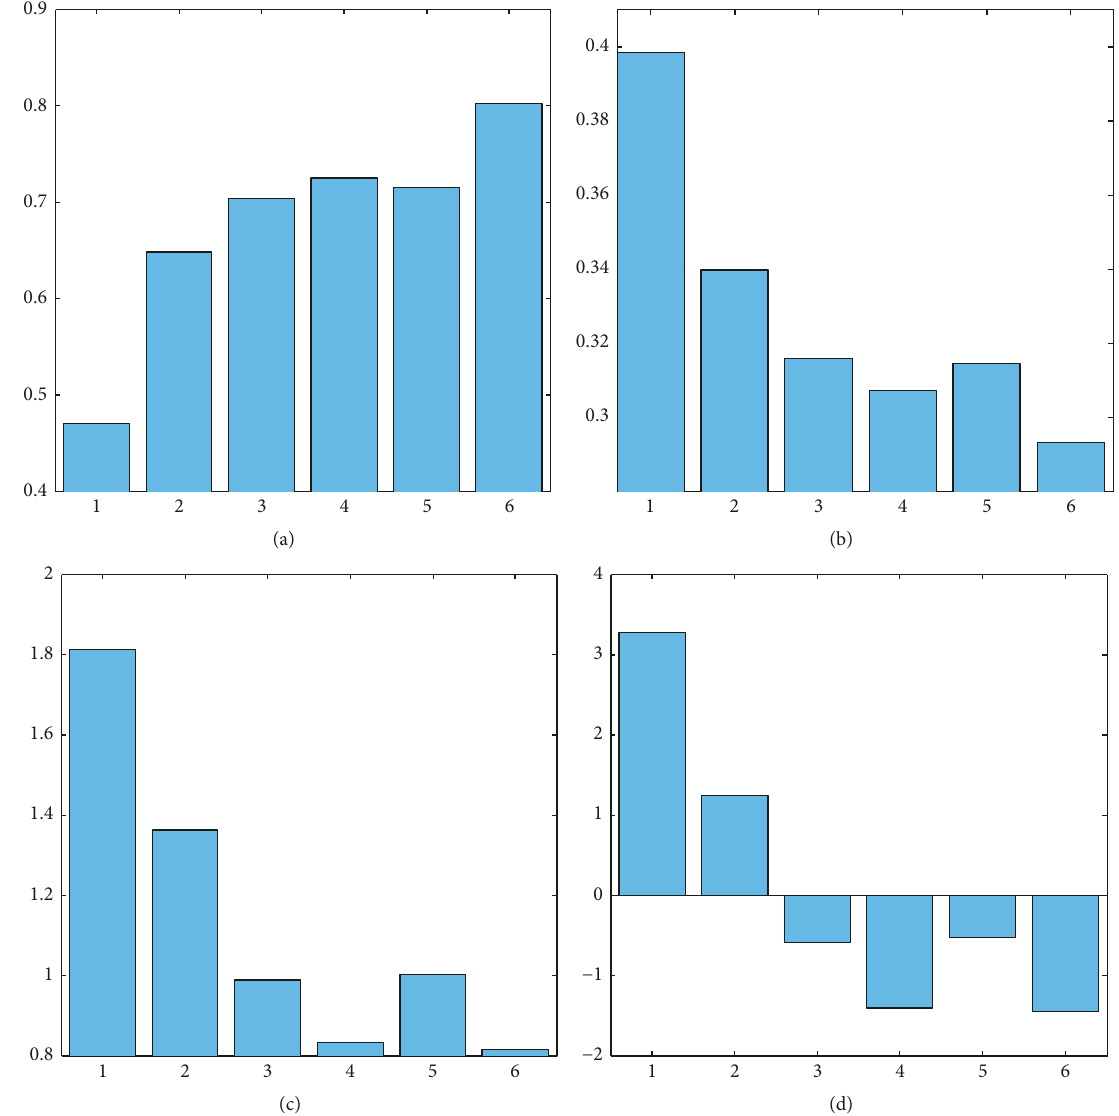
Figure 3: Four indexes changes with age: (a) entropy, (b) standard deviation, (c) skewness, and (d) kurtosis.